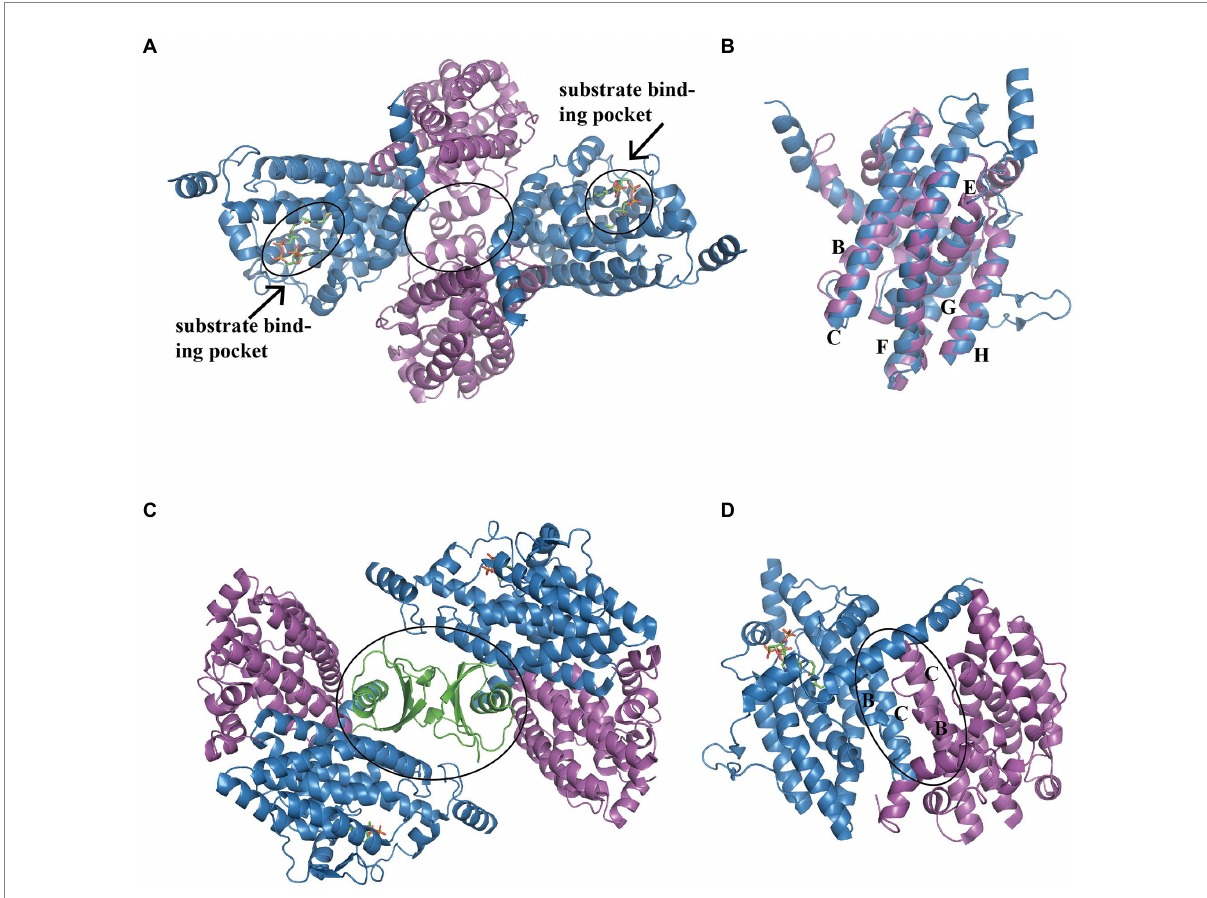
FIGURE 3 Overall structure of the PaaACB complex. (A) The overall structure of heterotetramer EcoPaaAC (PDB:3PW8), the substrate acetyl-CoA in binding pocket is shown as sticks, the complex is formed by interactions in PaaC, circled with a solid line. (B) Structure superposition of PaaA and PaaC; the core helixes are labeled as reported previously (Grishin et al., 2011). (C) The PaaAC heterodimer formed by interactions between helixes B and C in each subunit. (D) The (PaaACB) 2 heterohexamer from Klebsiella pneumoniae (PDB:4IIt) maintained by the dimerization of PaaB, constructing a β -barrel in the center part. PaaA, PaaC, and PaaB are in blue, magenta, and green,